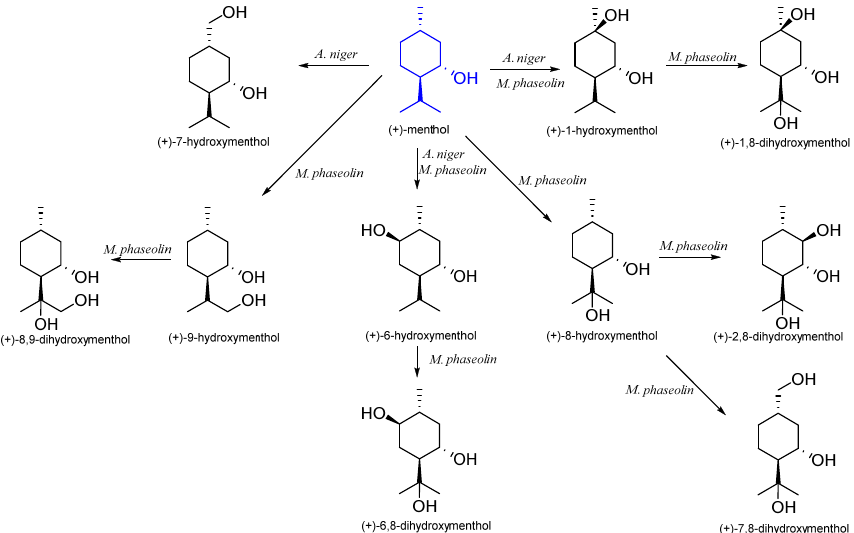
Scheme 11. Microbiological biotransformations of (+)-menthol.